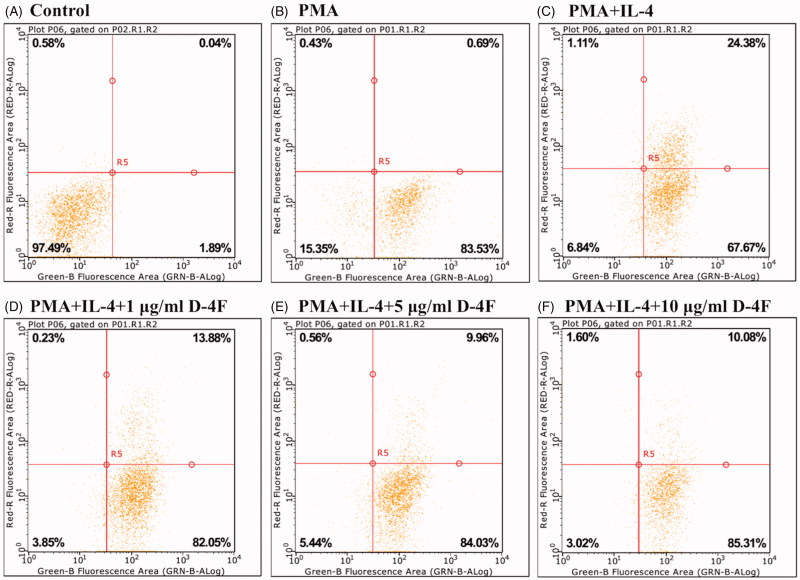
IL-4 alternatively activates MDMs and D-4F suppresses IL-4 induced alternative activation. Flow cytometry was performed on cells treated with medium control (A), PMA (B), IL-4 (C), IL-4 and 1 μg/mL of D-4F (D), IL-4 and 5 μg/mL of D-4F (E), and IL-4 and 10 μg/mL of D-4F (F). Green-B fluorescence area represented cells labeled with macrophage specific F4/80 antibody (FITC) and Red-R fluorescence area represented cells reacted with M2 macrophage specific CD163 antibody (Alexa Fluor).